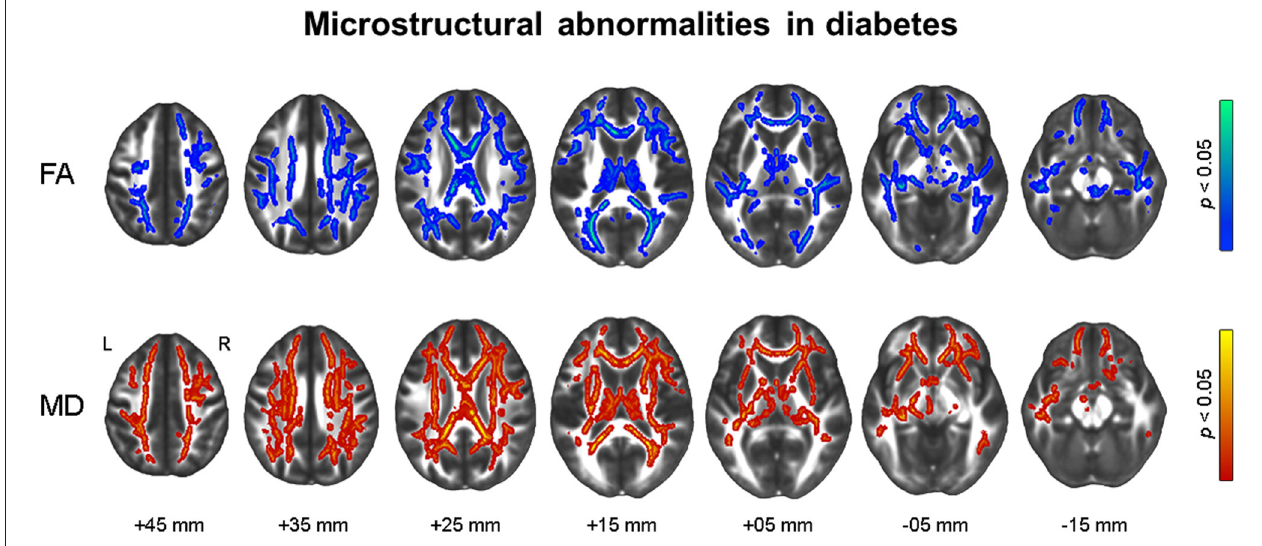
FIGURE 2 | Results of tract-based spatial statistics analysis showing microstructural alterations in diabetes. Threshold-free cluster enhancement and family-wise corrected p < 0.05 using nonparametric test. Red color indicates an increase, and blue color indicates a decrease in microstructural measures in diabetes compared to normal glucose tolerance. FA, fractional anisotropy; MD, mean diffusivity.